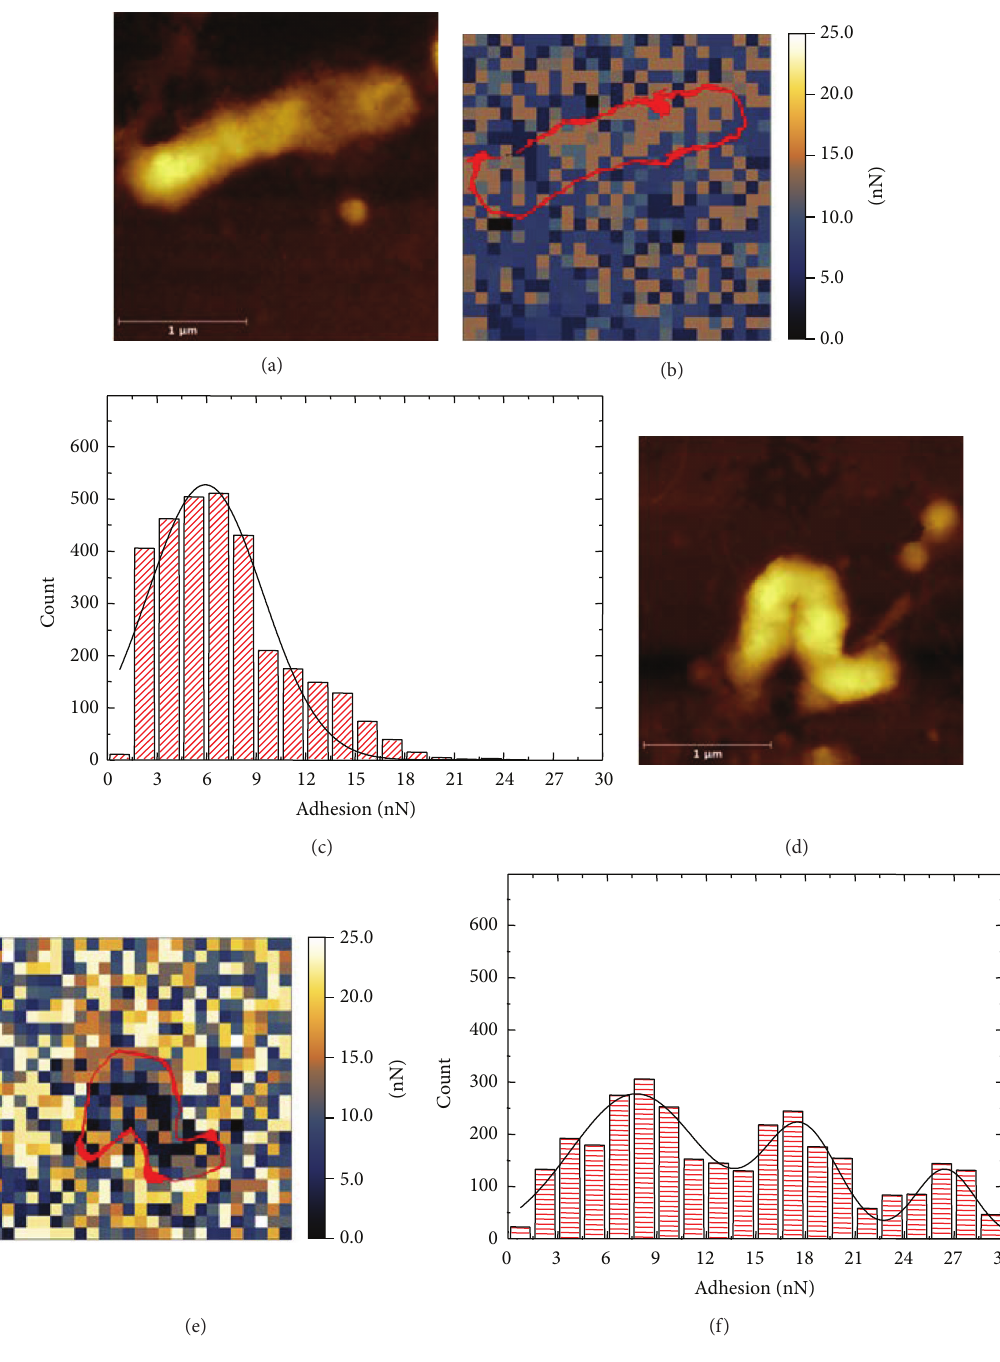
Figure 3: Adhesion force maps of H. pylori biofilm: (a) representative high-resolution image ( 2.3 × 2.3𝜇 m) of H. pylori before treatment (a) and after treatment with AlgL (d). Representative adhesion force maps ( 25 × 25 pixels) with shadows of bacteria (red lines) were shown for H. pylori before treatment (b) and after treatment with AlgL (e). Histograms and Gaussian fit (black lines) obtained from five different maps for H. pylori before treatment (c) and after treatment with AlgL